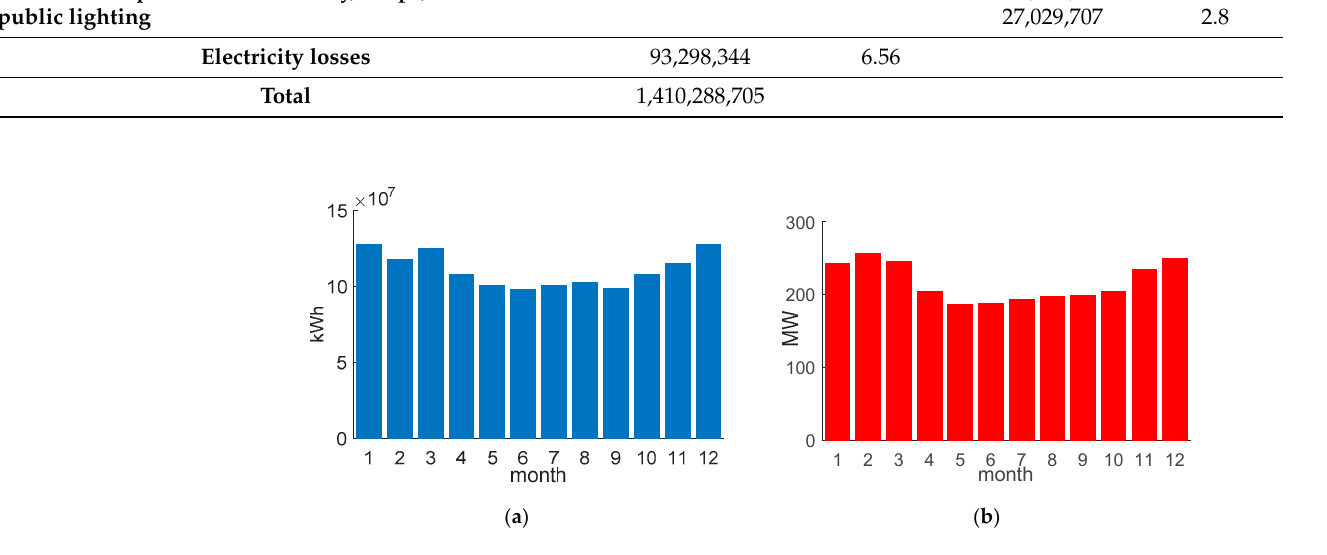
Figure 3. ( a ) Monthly electricity consumption in Sarajevo Canton for 2018, ( b ) Maximum active power measured in Sarajevo Canton for 2018 [29].